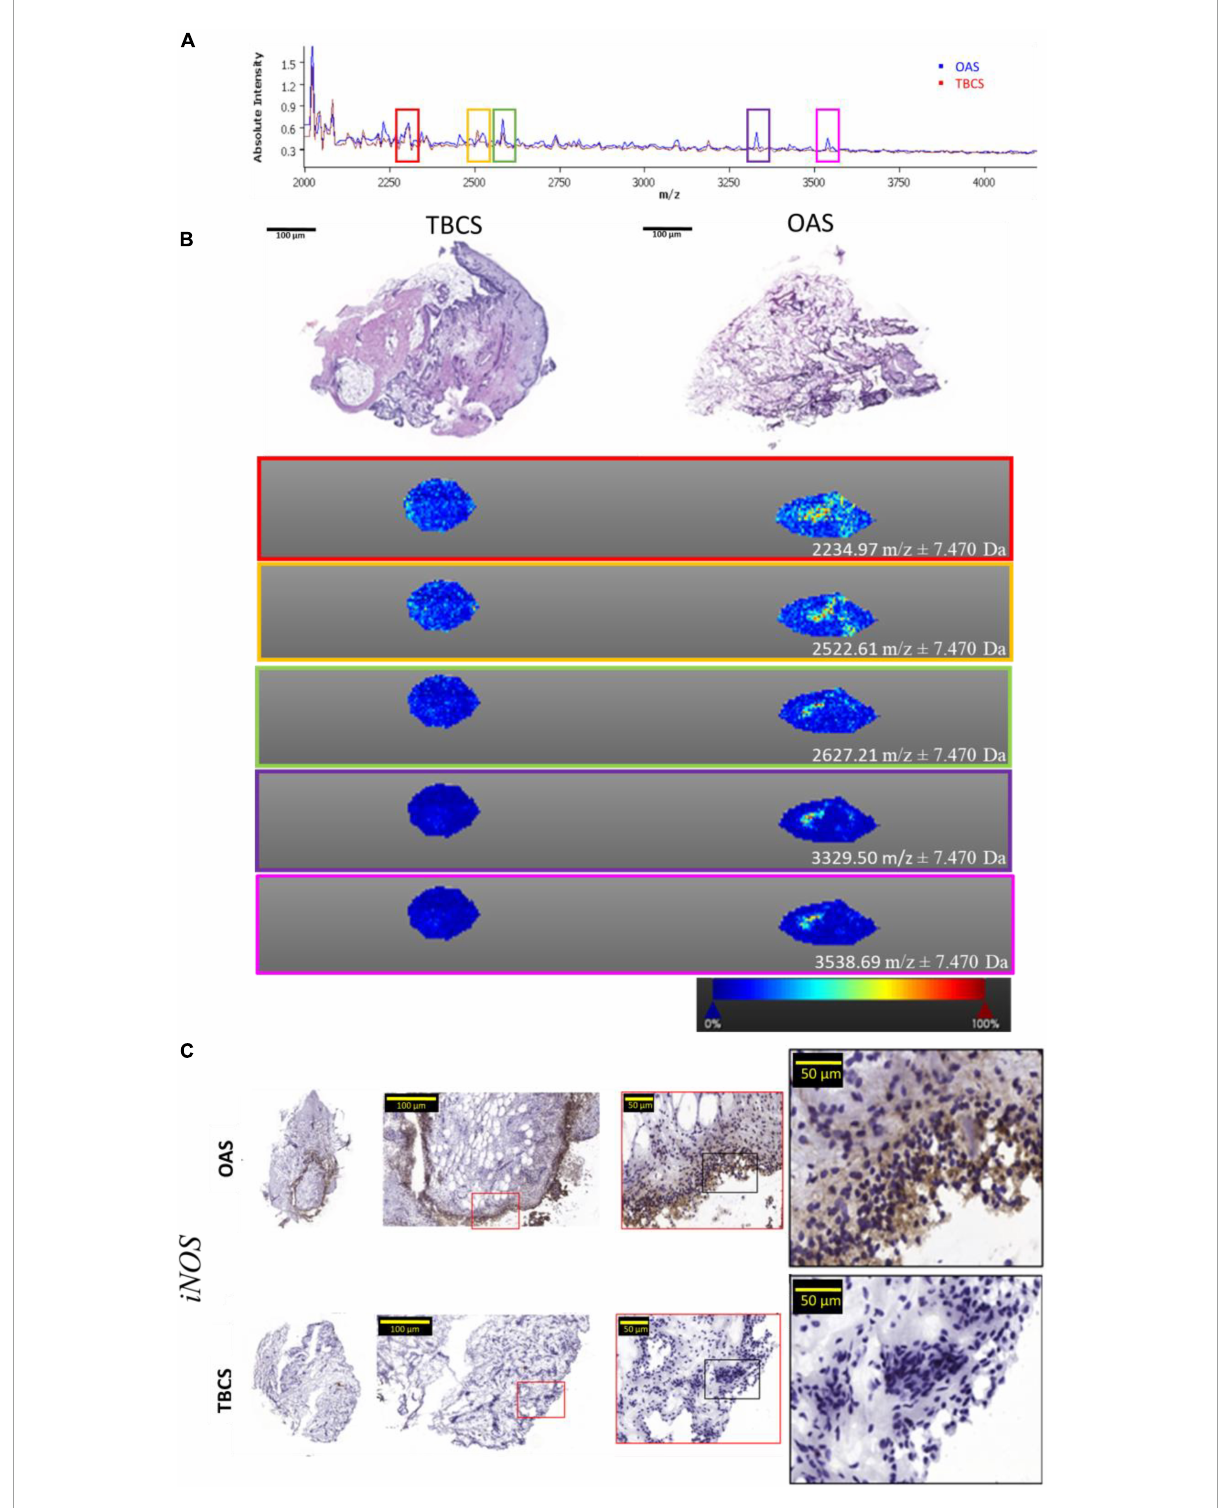
FIGURE4 The localized protein profile in OAS and TBCS. (A) MALDI spectra; (B) H&E staining of histological section and its corresponding MALDI imaging; (C) Expression of the pro-inflammatory marker, iNOS in mononuclear